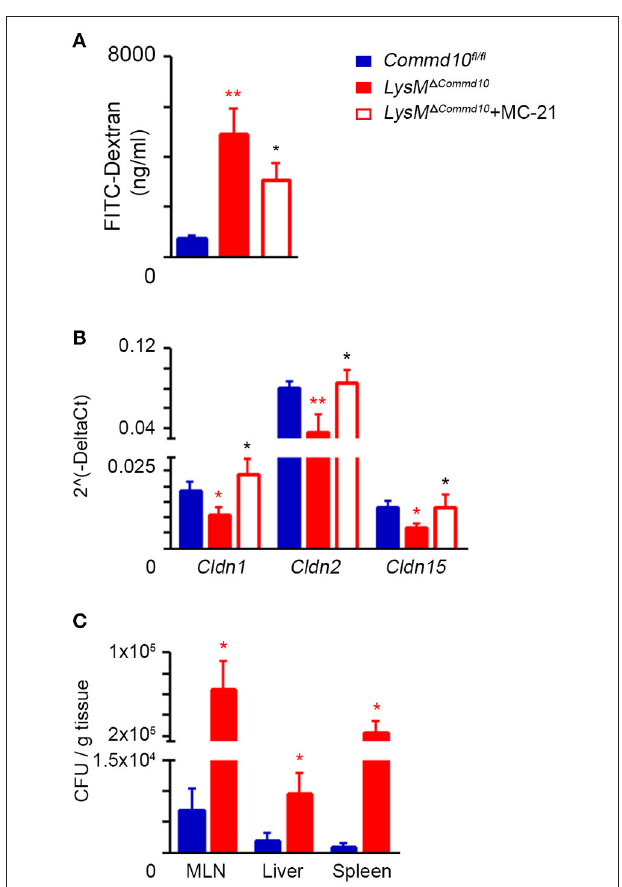
FIGURE 4 | Increased intestinal barrier dysfunction in LPS-challenged LysM 1 Commd 10 mice driven by Ly6C hi monocytes. Commd10 fl / fl (blue) and LysM 1 Commd 10 (red) mice were i.p. injected with LPS (0.2mg per mouse of similar weight) and sacrificed 24 or 48h later. Where indicated, MC-21 was injected 12h prior to LPS stimulation and every 24h (red border). (A) Fluorometric assessment of FITC dextran plasma signal at 4h following its oral administration to mice after 24h of LPS challenge ( n ≥ 6). (B) Graphical summary of qRT-PCR assessment of Claudin 1, 2, and 15 gene expressions at 48h following LPS challenge ( n ≥ 7). (C) Indicated tissues were extracted at 48h following LPS injection. Colony forming units (CFU) were determined and normalized to tissue mass ( n = 4). Data were analyzed by unpaired, two-tailed t- test, comparing each time between Commd10 fl / fl and LysM 1 Commd 10 (red stars) or between LysM 1 Commd 10 mice with and without MC-21 treatment (black stars). Data are presented as mean ± SEM with significance: * p <